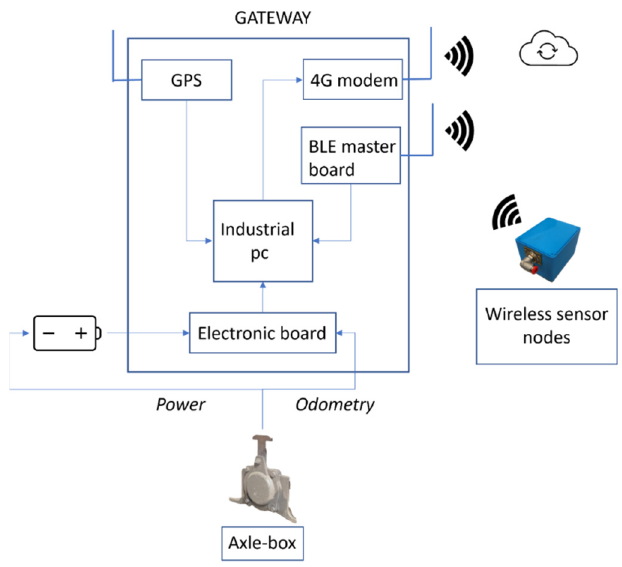
Figure 11. Data collector architecture.